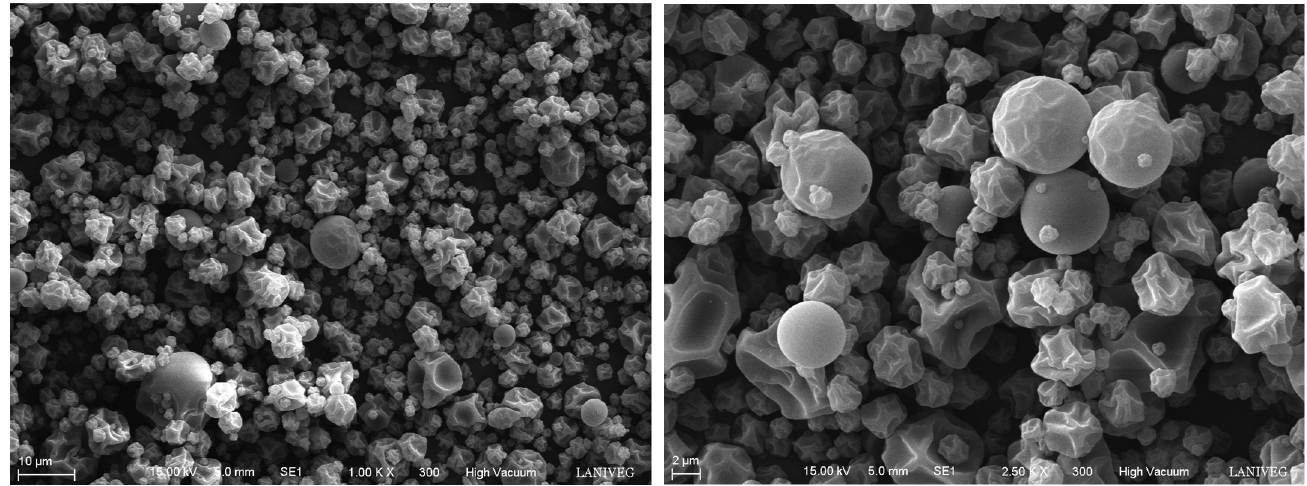
Figure 2. Micrographs of the microparticle structure of oregano ( Lippia graveolens ) flavonoids pro- duced with maltodextrin 10 DE as wall material, using spray drying.